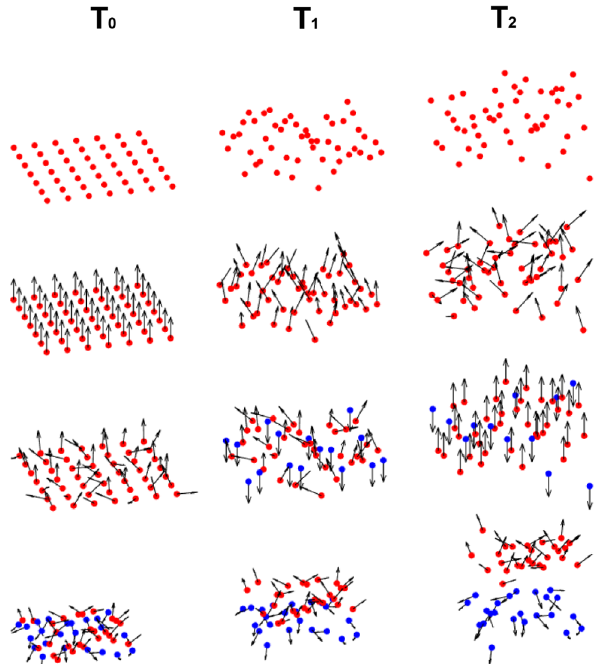
FIG. 2. Sketch of basic processes that need to be discussed in a laser-plasma accelerator for polarized particle beams. 1st line: Pure kinetic evolution of an initially ordered particle ensemble in strong fields. 2nd line: Same kinetic evolution as in the first line for an initially polarized particle beam. The black arrows indicate the single particle spins which are treated in a semi-classical limit following the T-BMT equation. 3rd line: The particles ’ positions evolve as in the previous lines but their initially unordered spins individually flip in z-direction (red dots for spin up and blue dots for spin down) such that a certain polarization builds up. The corresponding mechanism is known as the Sokolov-Ternov effect. Last line: If the Stern-Gerlach force (or its mean) acts constantly for a longer time on an initially unpolarized and spatially unordered ensemble, we expect a certain beam split-up such that two polarized beams (red dots for spin up and blue dots for spin down)